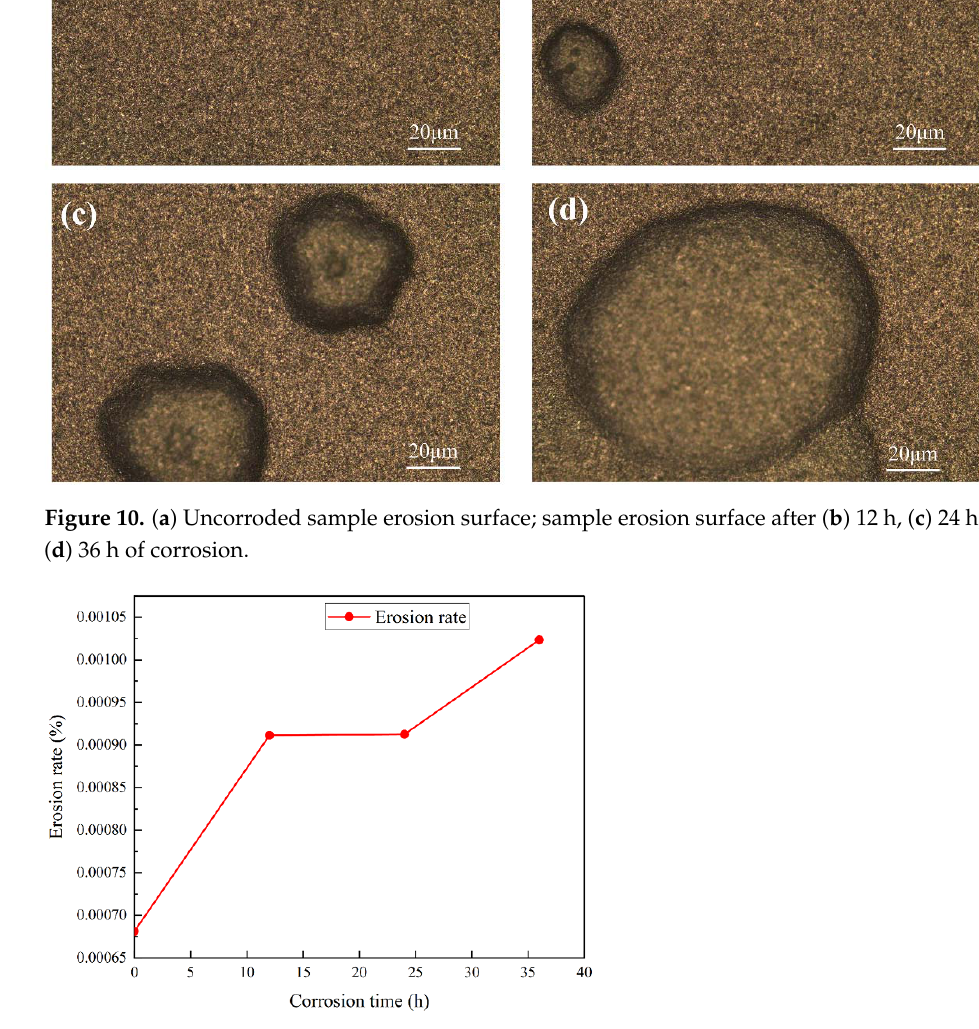
Figure 11. Erosion rate change curve during the erosion process. Table 6. Sample mass before and after erosion.